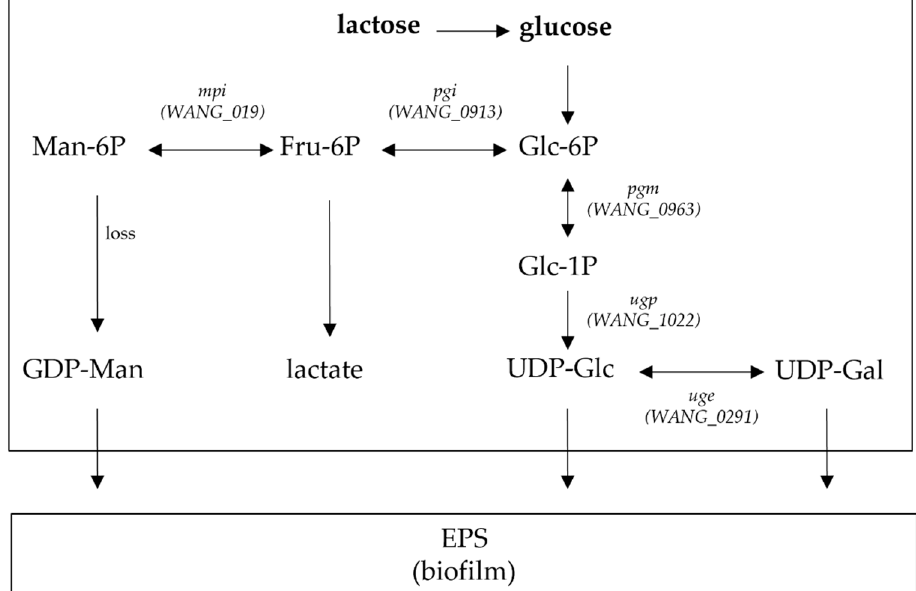
Figure 4. The proposed biosynthesis pathway for EPS production according to KEGG analysis [104]. mpi : mannose-6-phosphate isomerase; pgi : glucose-6-phosphate isomerase; pgm : α -phosphoglucose mutase; ugp : UDP-glucose pyrophosphorylase; uge : UDP-galactose 4-epimerase.